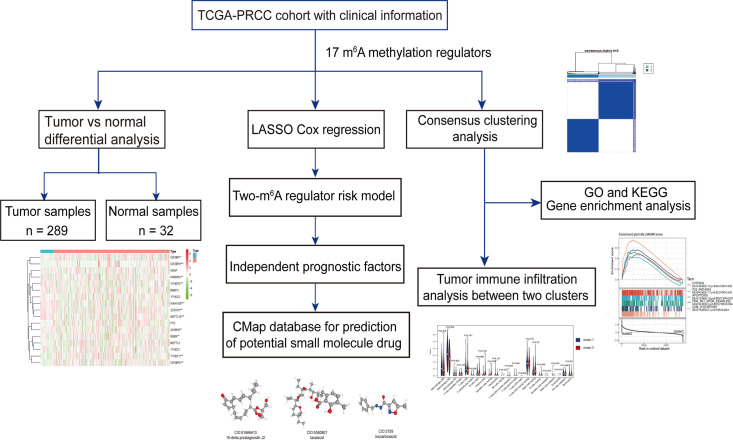
Workflow of this study.